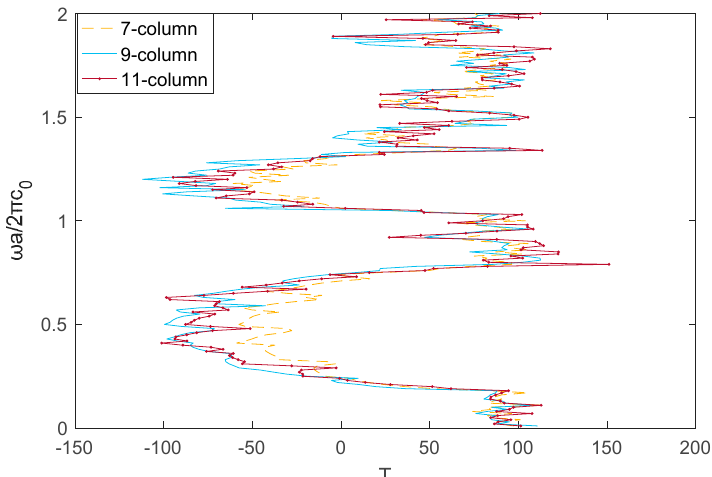
Figure 11. Transmission spectra aurum/epoxy phononic crystal with circular scatterer, along with 7-column, 9-column and 11-column finite periodic structures.